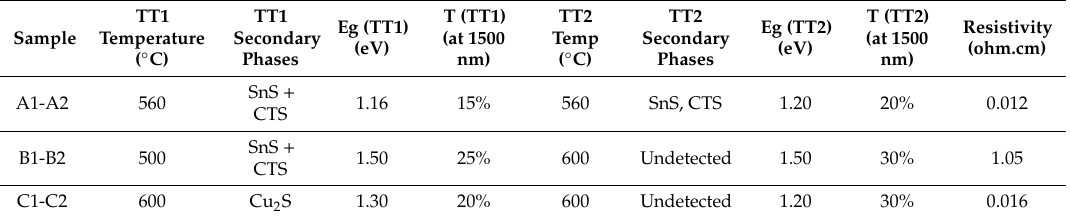
Table 3. Resistivity of samples after di ff erent thermal treatments. The values of the band gap energy (Eg) and of the transmittance at 1500 nm after TT1 and TT2, the type of secondary phases detected by XRD after TT1 and by Raman after TT2 are also reported.